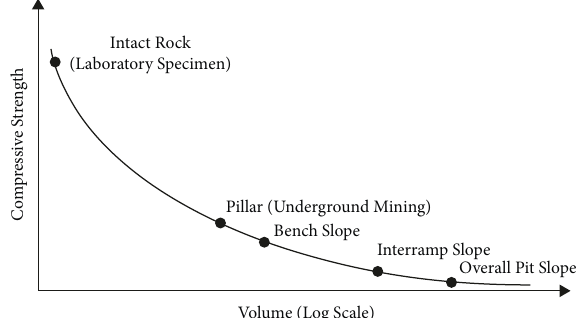
Figure 5: The scale effect on rock mass compressive strength